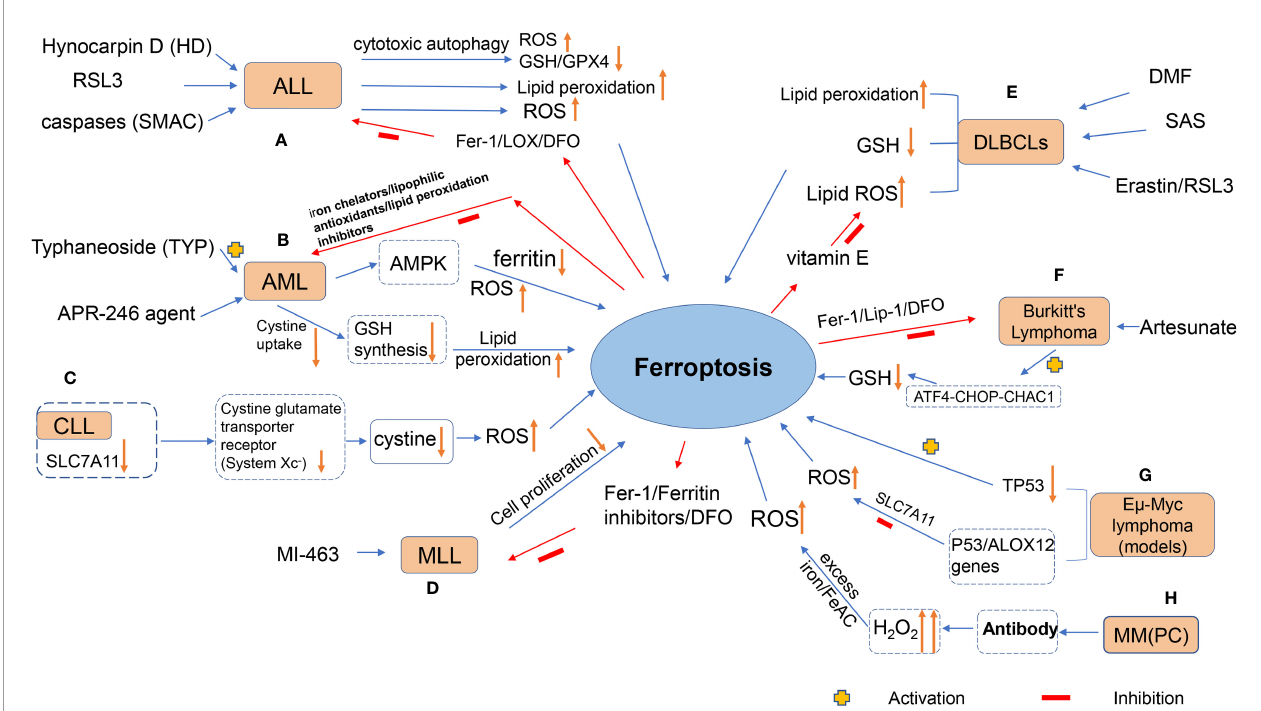
FIGURE 2 | The fi gure shows the agents or mechanisms that regulate ferroptosis in animal models or patients with hematological malignancies. (A) Treatment of ALL cells with HD, RSL3 and SMAC resulted in ferroptosis with increased lipid peroxidation levels, which was inhibited by antioxidants and DFO; (B) TYP treatment of AML cells could lead to ferroptosis in AML cells through activation of AMPK signaling, accompanied by ferritin degradation and ROS accumulation; APR-246 action on AML cells decreased cystine uptake, resulting in decreased GSH synthesis and lipid peroxidation in the cell membrane (this effect can be inhibited by iron chelators, lipophilic antioxidants and lipid peroxidation inhibitors); (C) Expression of SLC7A11 would de fi nitely be down-regulated in CLL cells, and system Xc- transporting cystine capacity could be reduced, leading to increased intracellular ROS and promoting cellular ferroptosis; (D) MI-463 action on MLL led to the inhibition of tumor cell proliferation by ferroptosis of its cells, which could be reversed by the use of ferroptosis inhibitors. (E) Treatment of DLBCLs with RSL3, Erastin, and DMF resulted in ferroptosis of cells accompanied by increased lipid peroxidation levels, increased ROS, and decreased GSH levels, which was inhibited by antioxidants, DFO, and vitamin E; (F) Artesunate induced ferroptosis in Burkitt ‘ s lymphoma(BL) cells by activating the ATF4-CHOP-CHAC1 pathway and degrading GSH; (G) p53 inhibited system Xc- and promoted ferroptosis in E m -Myc lymphoma cells, while deletion of TP53 gene accelerated the formation of E m -Myc lymphoma model; (H) MM could generate lipid ROS through high levels of H 2 O 2 , a byproduct of antibody production, which reacted with excess iron in the Fenton reaction, thereby destroying the cell membrane and causing cell